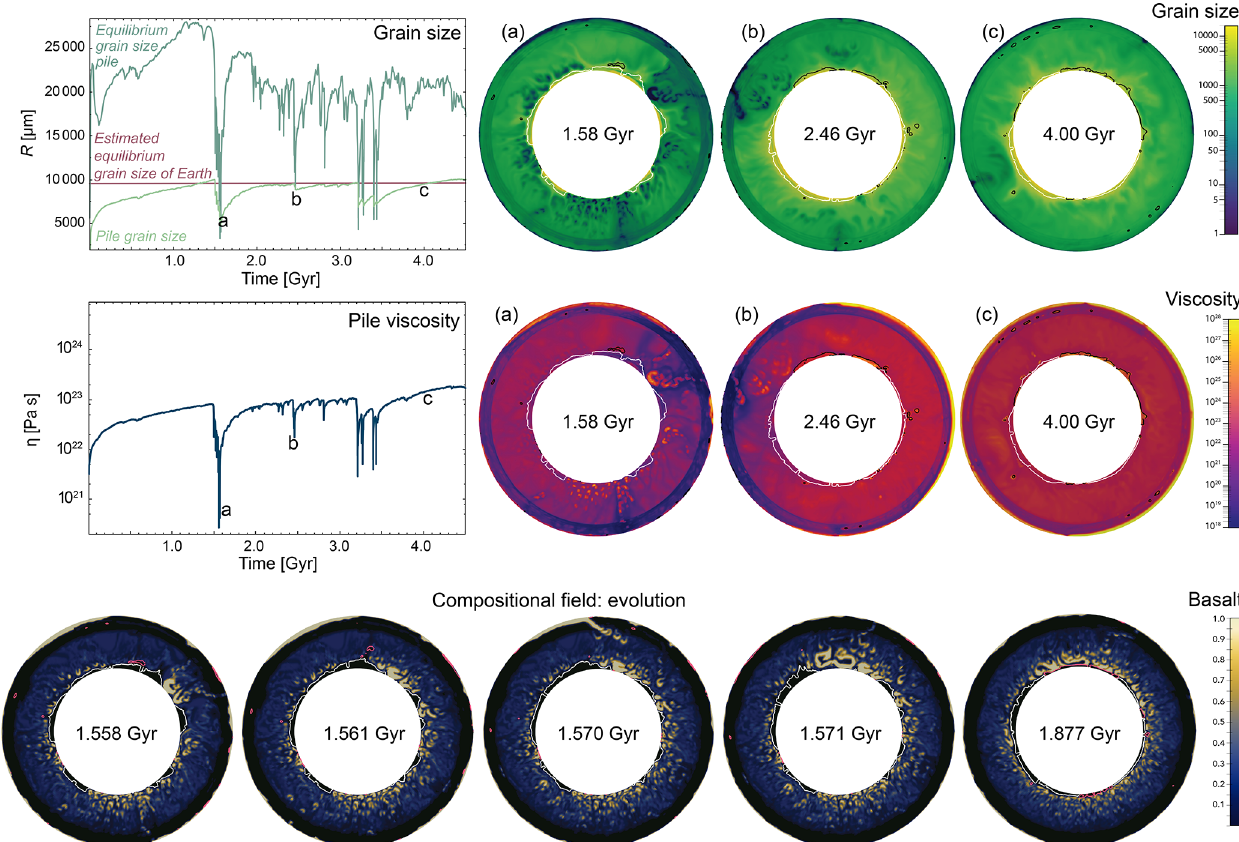
Figure 3. Example of the dynamics of grain size and viscosity during an overturn (1.58Gyr), during the mobile-lid phase (2.46Gyr) and the stagnant-lid phase (4.0Gyr). The white line outlines the pile and the black line outlines regions with a partial melt percentage higher than 50% (viscosity and grain size in these regions only refer to the solid). On the bottom, the evolving distribution of basalt is displayed. Outlined in white is again the detected pile. In red this time are the regions with partial melt. It can be observed that basalt does not mix with the pile but pushes it